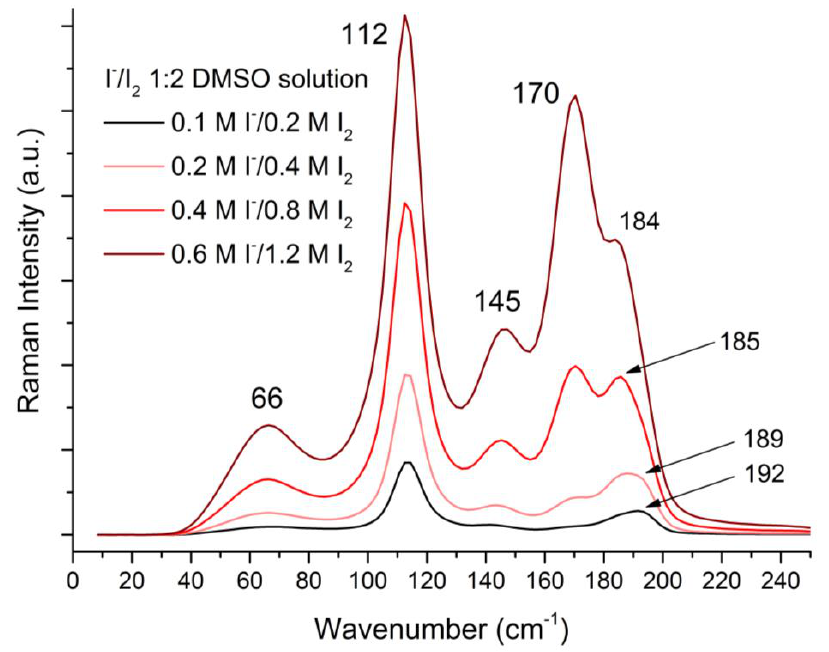
Figure 9. Raman spectra of DMSO I − /I 2 1:2 solutions at different concentrations showing the concentration-dependent presence of a strong band at 170 cm −1 , diagnostic of V-shaped I 5 − .